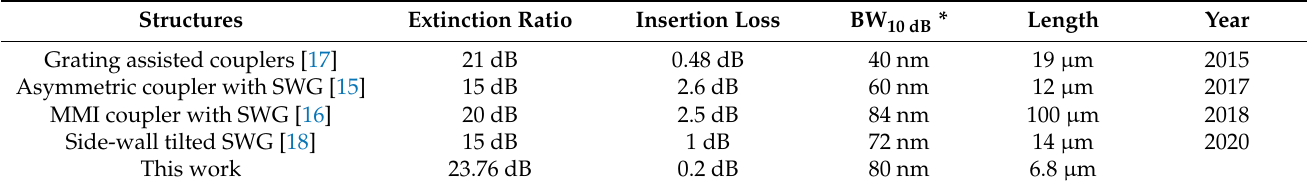
Table 1. Comparison of different types of PBSs reported